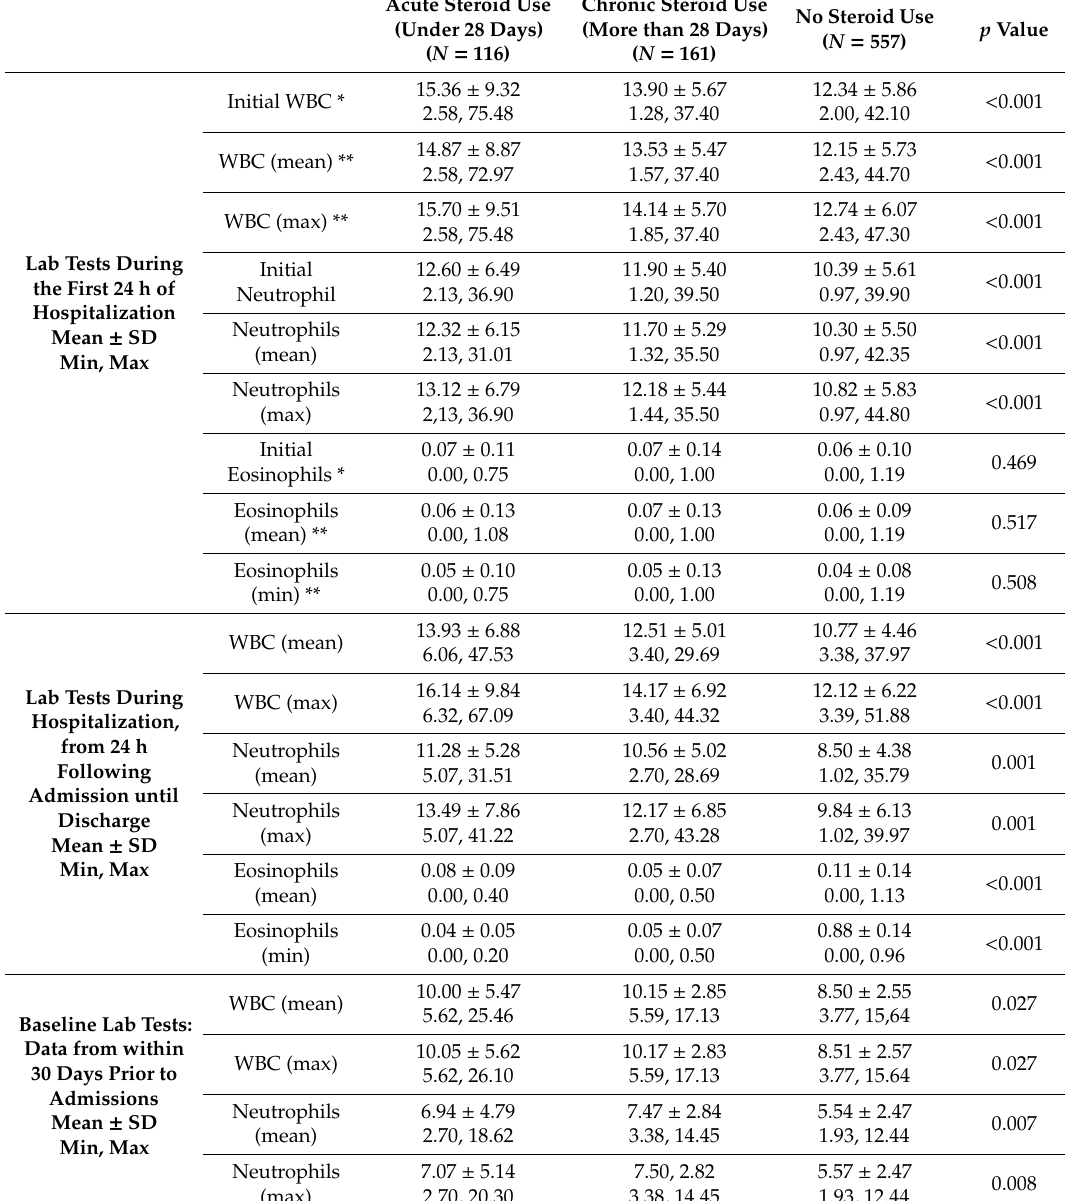
Table 2. Comparison of laboratory tests between the